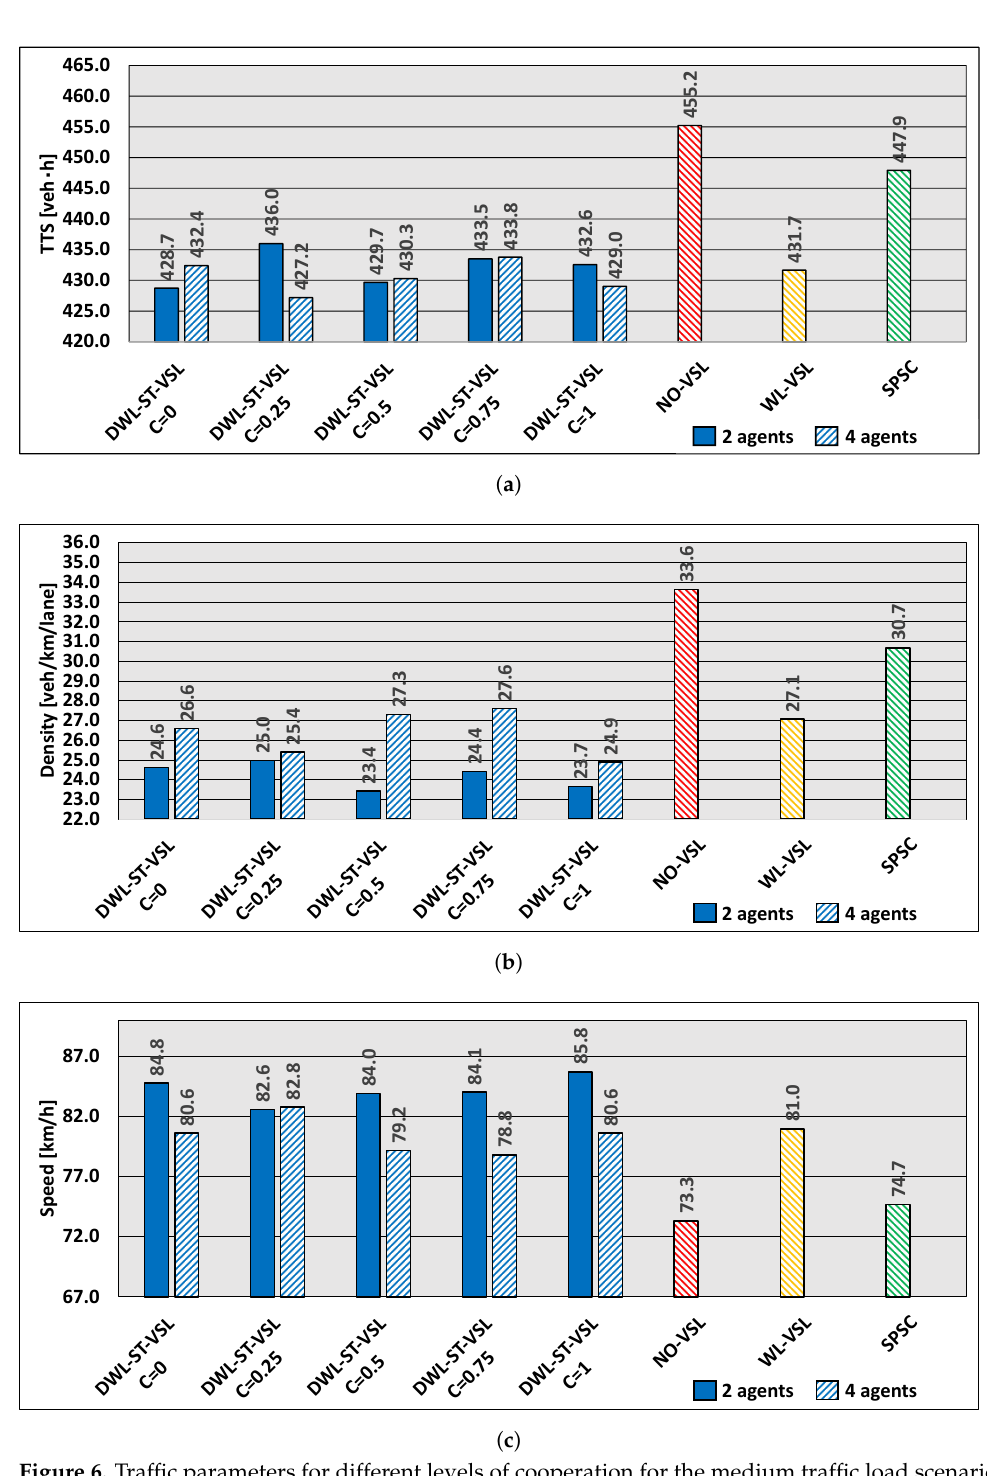
Figure 6. Traffic parameters for different levels of cooperation for the medium traffic load scenario. ( a ) TTS in the overall network. ( b ) Average traffic density in section S 0 . ( c ) Average vehicle speed in section S 0